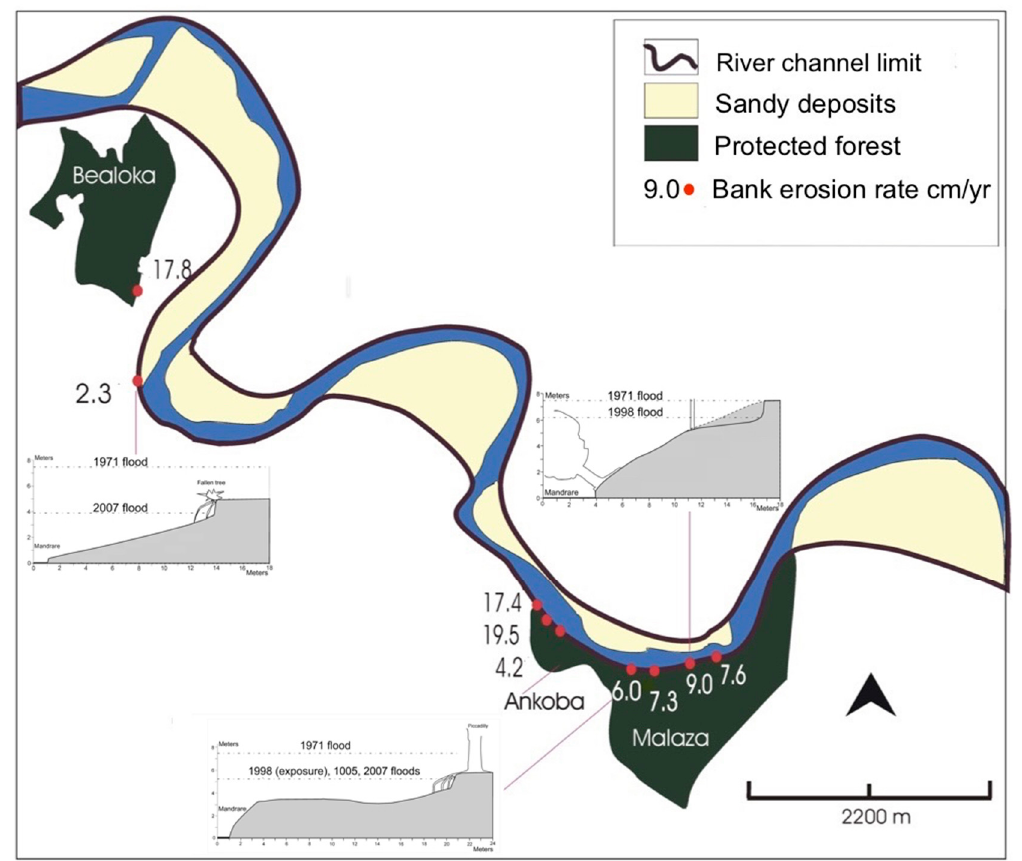
Figure 9. Berenty Reserve with the Mandrare river at low water and the range of different bank profiles with dated flood heights: 1971 was the highest flood on record. The local people practice transient cultivation on inside channels and bends.